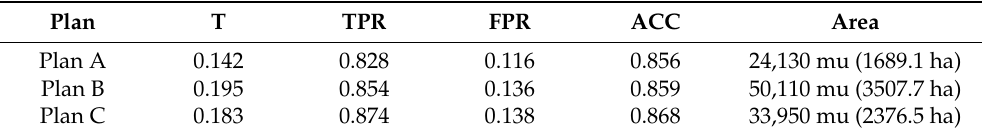
Table 6. DTW threshold and winter wheat extraction results of the combined time series of the optimal phenological period combinations in the study area.